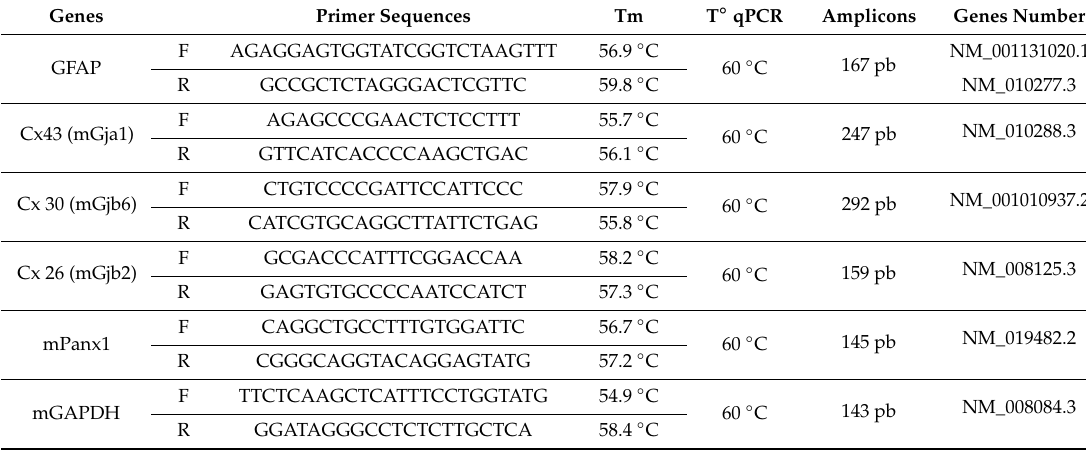
Table 1. Primers sequences used for SYBR Green